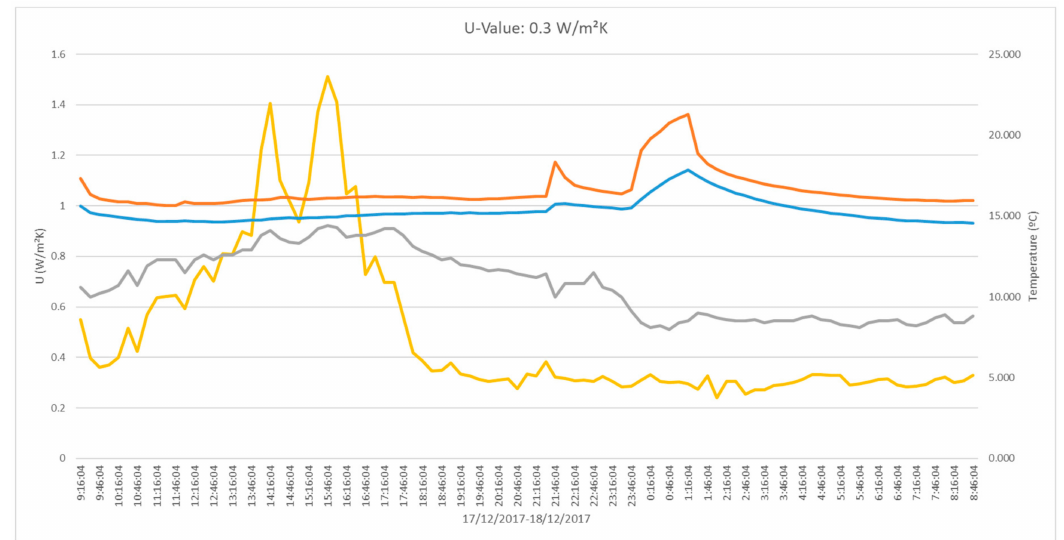
Figure 19. Dwelling envelope thermal transmittance test after refurbishment.